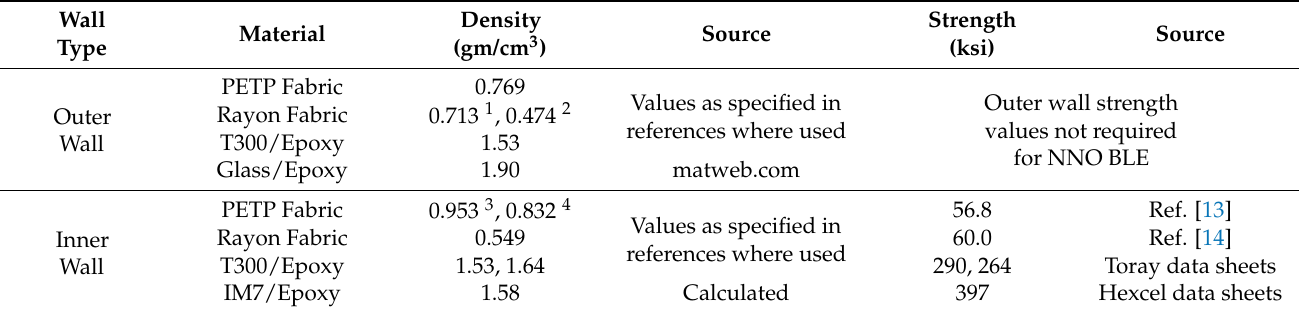
Table 3. Density and Strength Values for Inner Wall